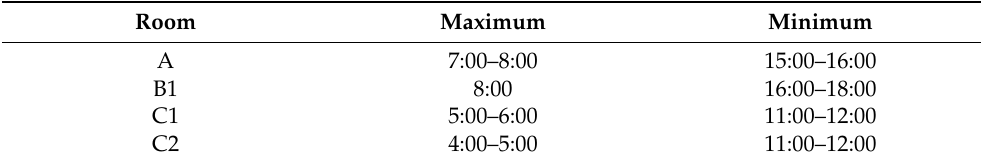
Figure 3. Daily dependence of radon for various measurement sites: ( a ) A, ( b ) B, ( c ) C1 and ( d ) C2. Table 7. Hours of maximum and minimum radon